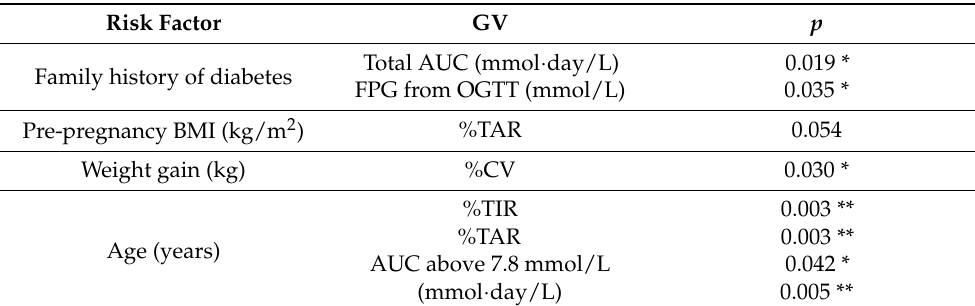
Table 4. Association between risk factors in pregnancy and GV. Risk Factor GV p Total AUC (mmol · Family history of diabetes